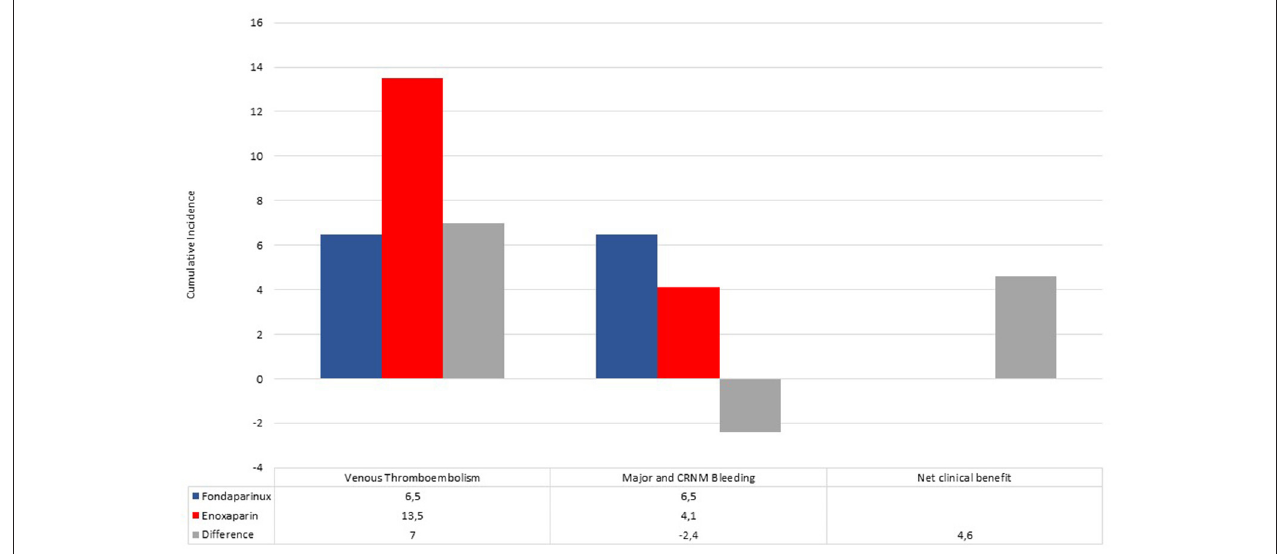
FIGURE 1 | Cumulative incidence of venous thromboembolism events, major and clinically relevant non-major bleedings in fondaparinux (blue bar) and enoxaparin (red bar) recipients. Differences (gray bar) between incidence rates were used to calculate the net clinical benefit (NCB).